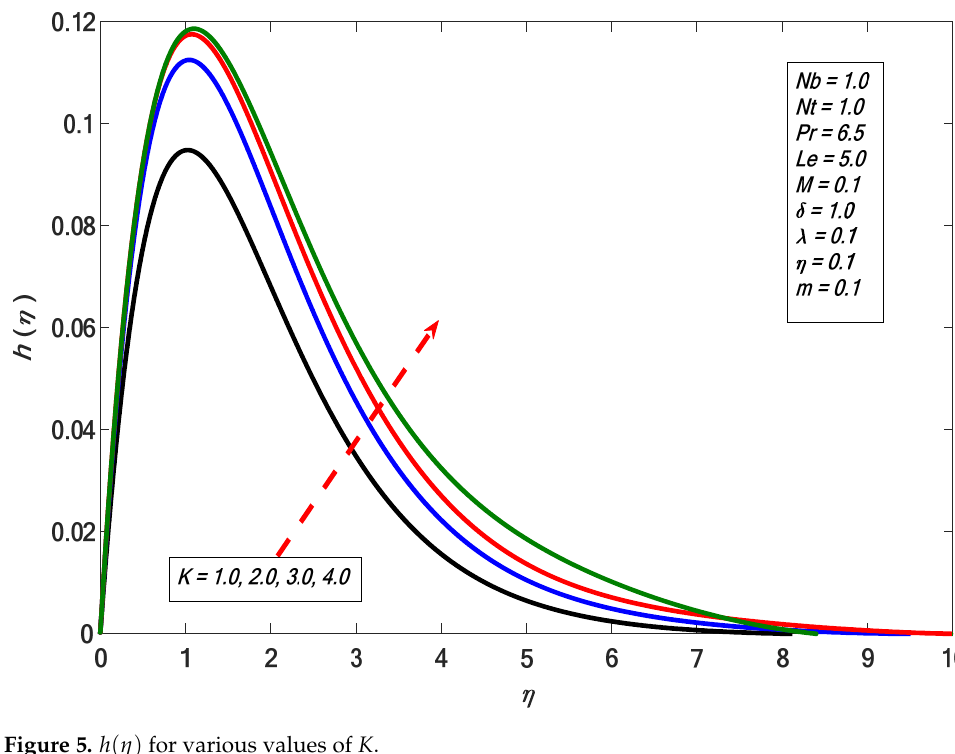
Figure 4. 𝑓′(cid:4666)𝜂(cid:4667) for various values of 𝑚.